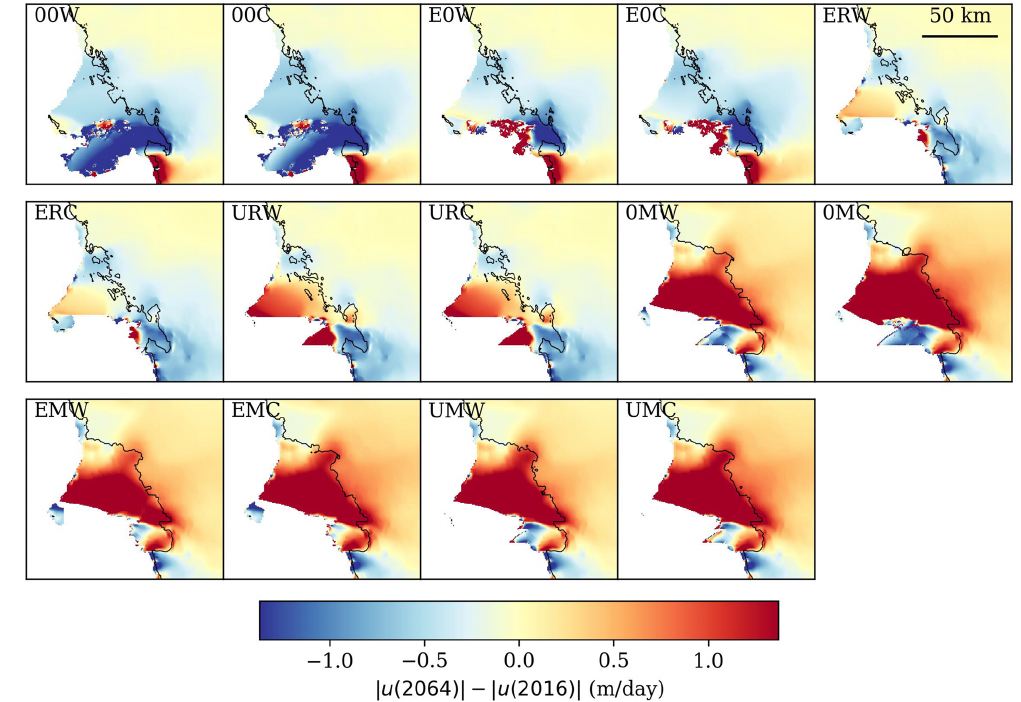
Figure A2. As Fig. 11, except showing differences in velocity between 2016 and 2064.